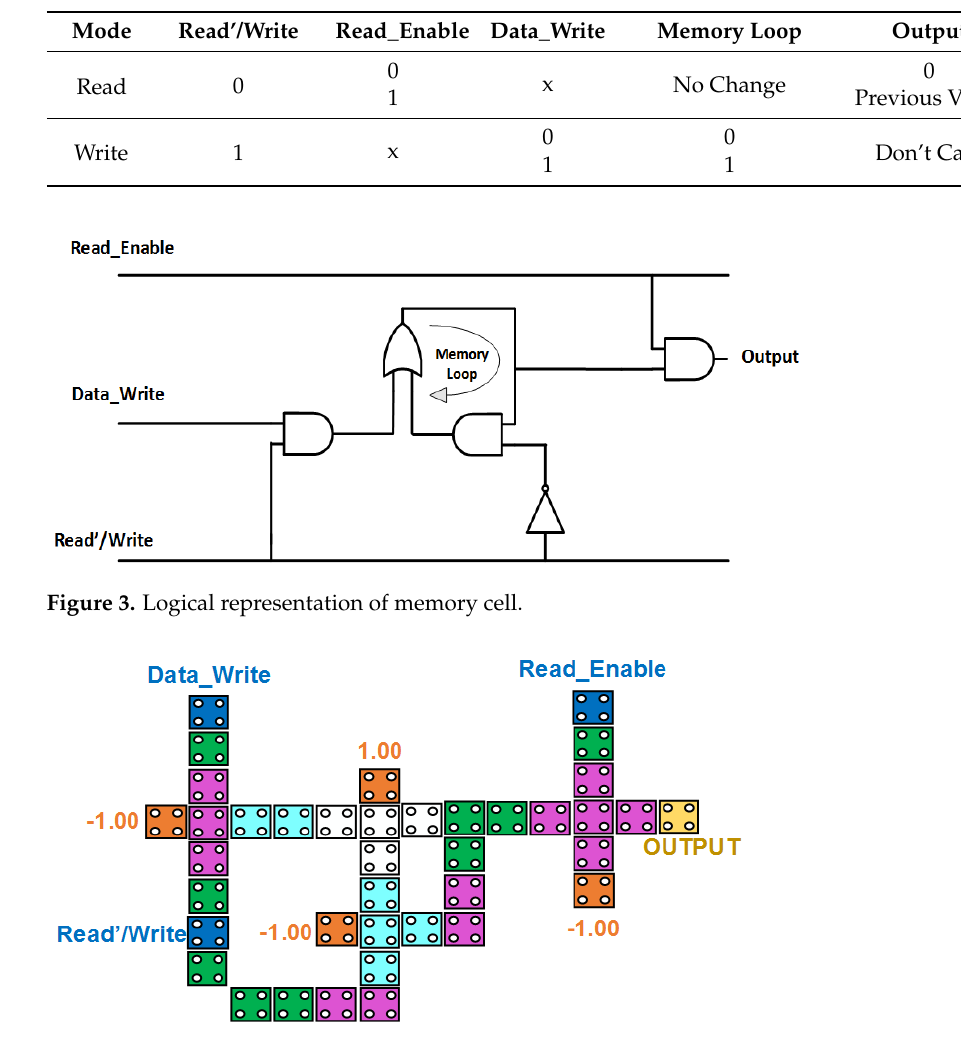
Figure 4. Implementation of a memory cell in QCA.